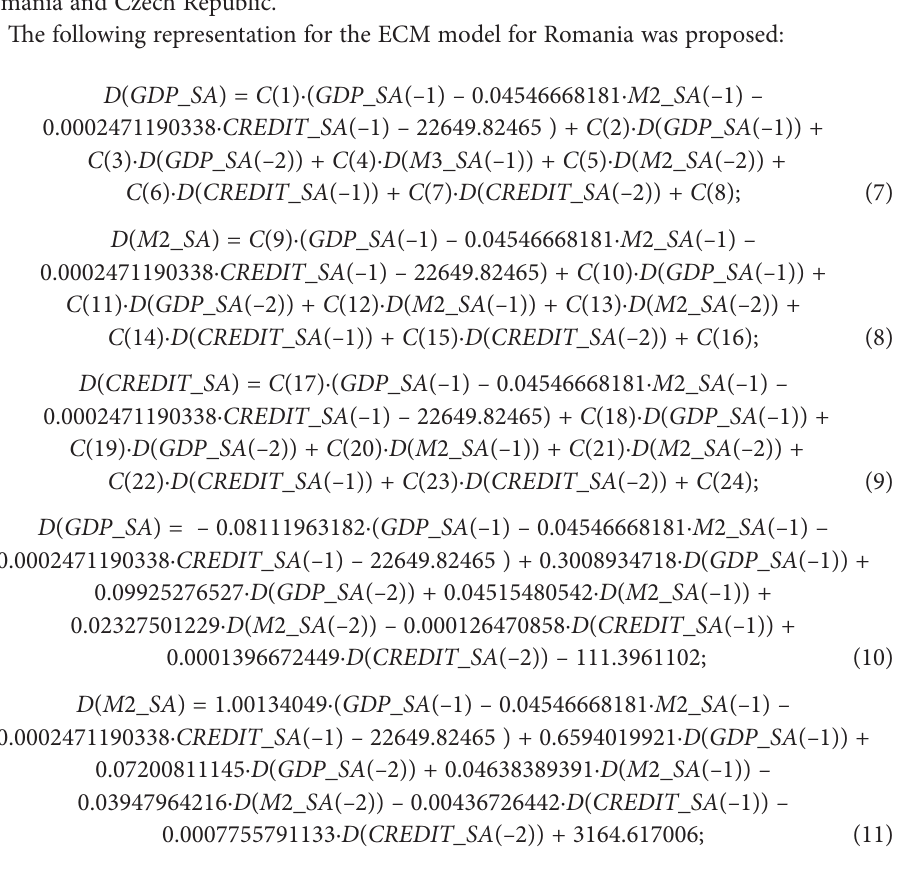
Table 5. Granger causality between economic growth and rate of M3 , respectively rate of internal credit in Czech Republic (source: authors’ calculations) Hypothesis F computed p-value Internal credit variation does not cause economic growth in 1.99034 0.14733 Granger approach Rate of M3 does not cause economic growth in Granger approach 0.81118 0.45009 Internal credit variation does not cause rate of M3 in Granger 2.04589 0.13995 approach M2 in double difference does not cause economic growth in 0.66471 Granger approach